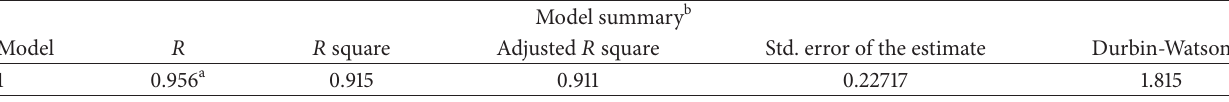
Table 3: Summary of multiregression analysis model for deflection.